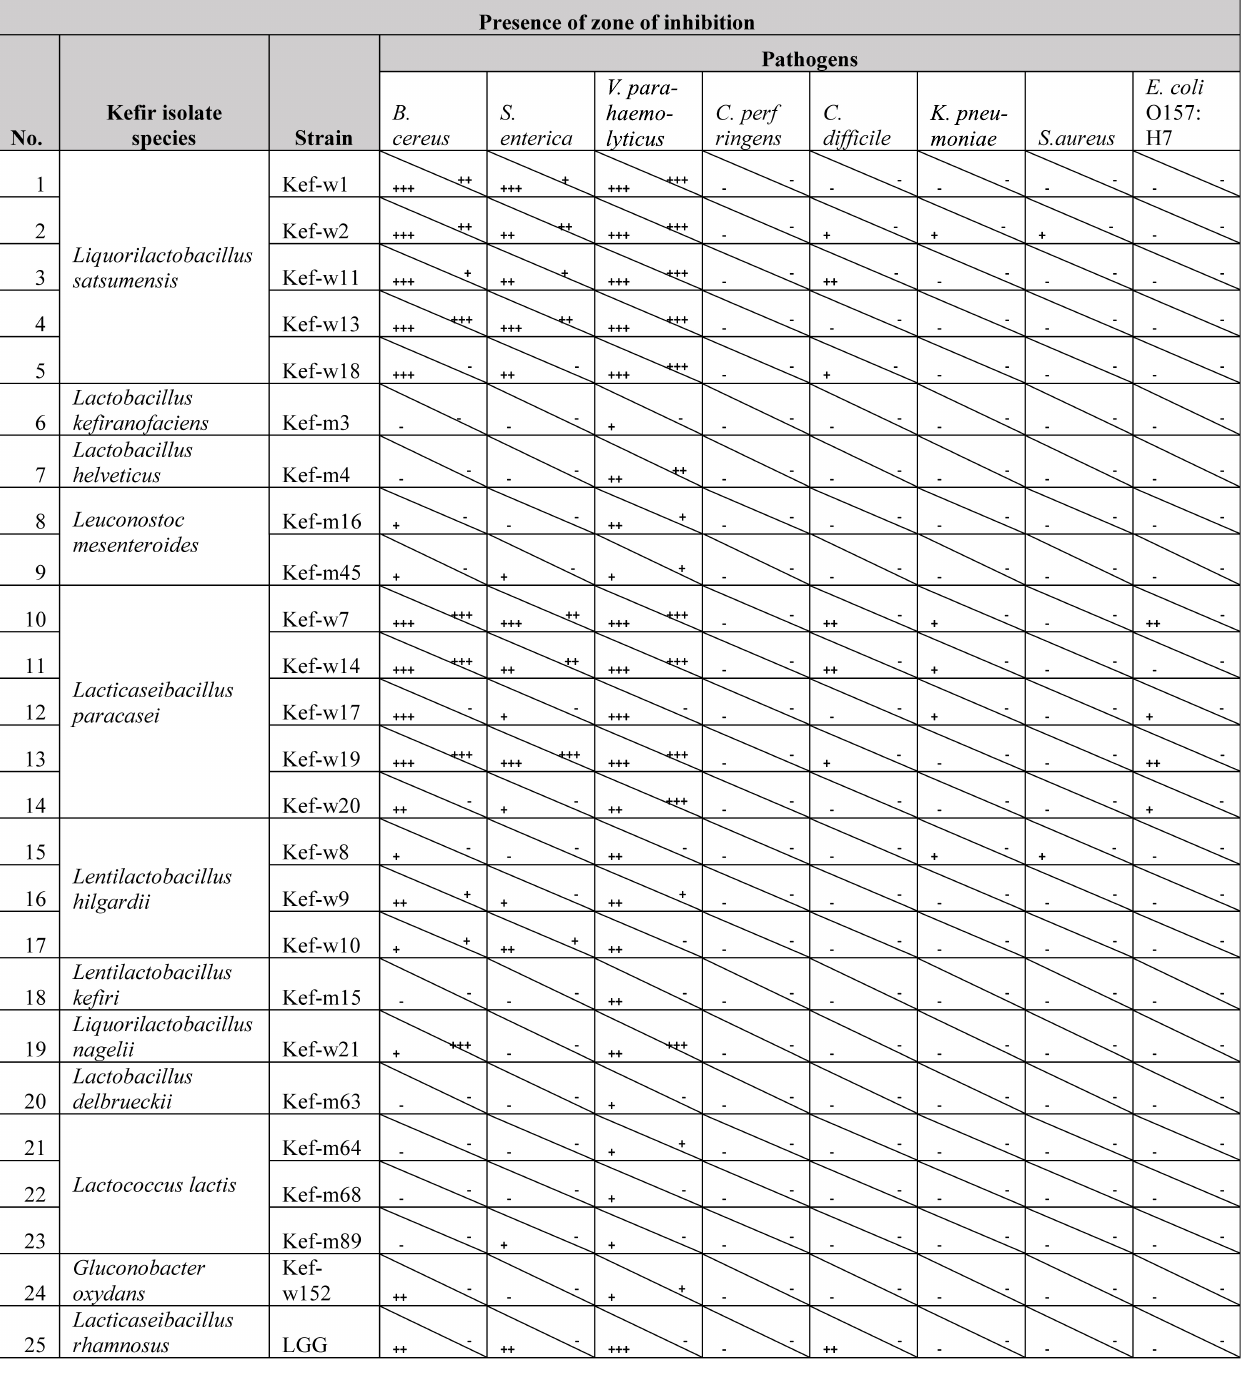
a The bottom-left triangle indicates inhibition by kefir isolate cultures, while the top-right triangle indicates inhibition by the cell-free supernatant component. Inhibition zones of > 4, 2–4, and < 2 mm were reviewed as strong ( +++ ), intermediate ( ++ ), and weak inhibition ( + ), respectively. Cells indicated with (-) are without any zone of inhibition observed. Only kefir isolates with inhibitory activities towards at least one tested pathogen are listed. Zones of inhibition were averaged from duplicate